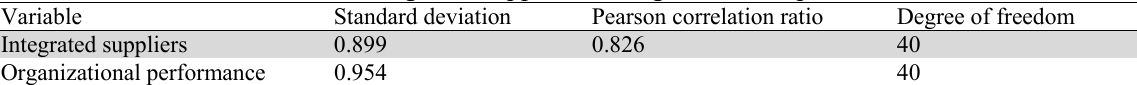
Pearson correlation test between integrated supplier and organizational performance Variable Standard deviation Integrated suppliers